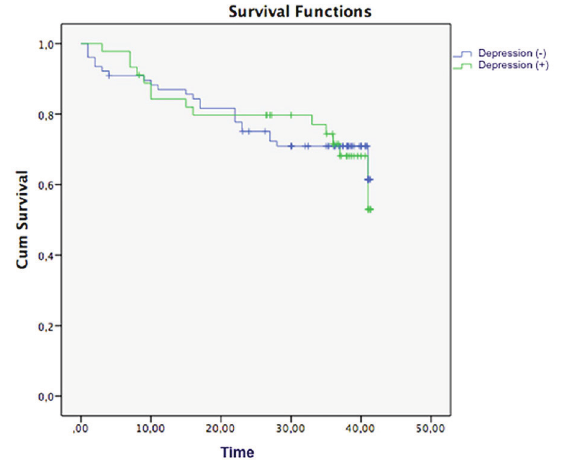
Figure 1 - Kaplan–Meier survival curves of the study population according to depression groups.